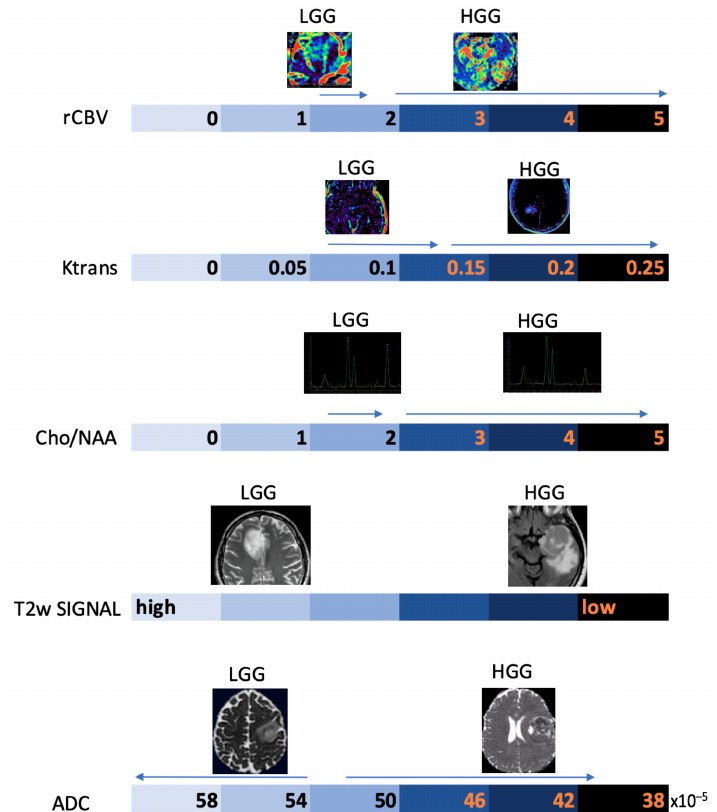
Figure 11. Schematic representation of the main MRI parameters used in the diagnostic work-up of gliomas on an arbitrary numerical scale, with indication of the main values associated with the degree of biological aggressiveness.